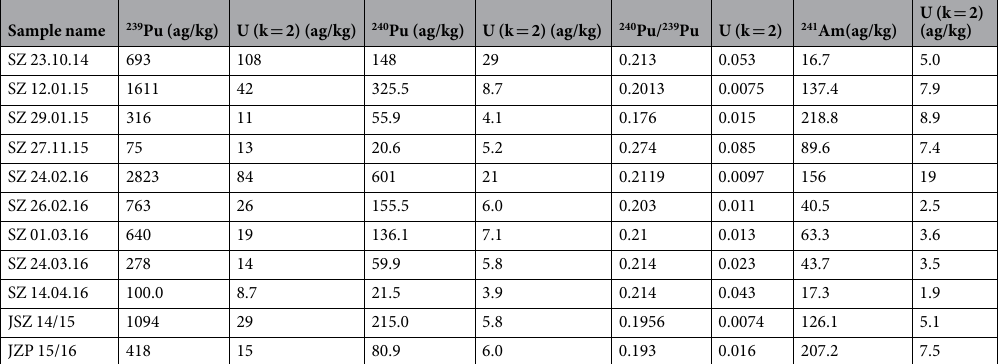
Table 4. Analytical results of 239 Pu, 239 Pu and 241 Am concentration and atomic ratio of 239 Pu/ 240 Pu in snow samples. U: expanded